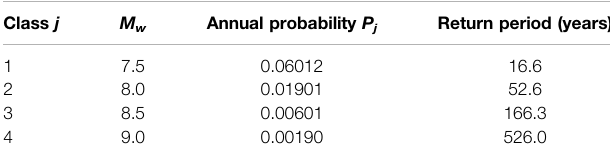
TABLE 1 | Table of the four magnitude classes used in this work, with the annual probability P j for an event from each class, along with the corresponding return period 1 / P j , based on the Gutenberg-Richter formula p (cid:2) 10 6 . 279 − M w for a magnitude M w